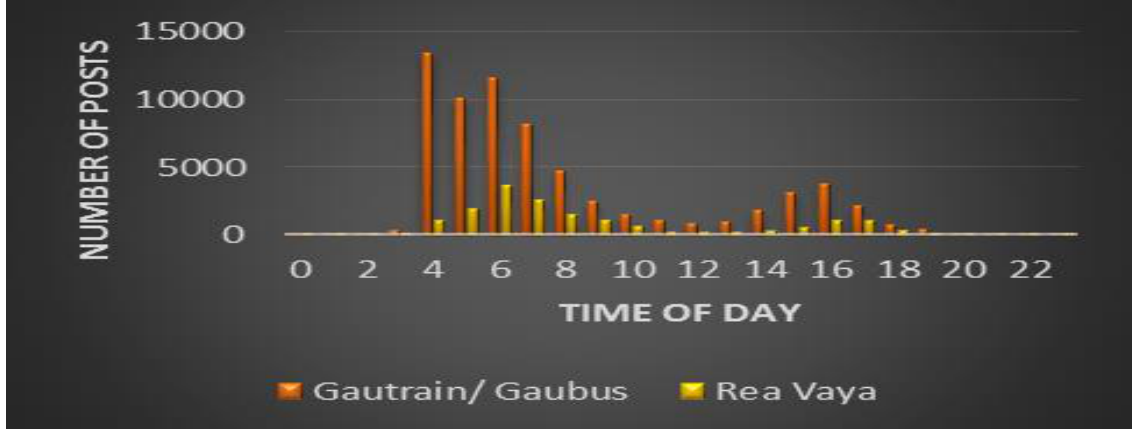
For the six month period in 2018, the highest numbers of trips both commuting and recreational occur in the during the morning peak for both modes of public transportation. This could be due to the commuters’ need for reducing the total travel time when going to work, school or making trips for administrative duties. From the content analysis, most of the posts made during this time are complaints are delays in travel time. From 12pm to 4pm, there is an increase in commuting trips, this Johannesburg there is usually an increase in traffic congestion during these times. This correlates to the results obtained from twitter, as most of the posts, related to traffic accidents on various major roads, and delays on the freeway. After 4pm there is a decrease in the number of posts. This could be due to having less commuters travelling during this time of day, as most commuters leave work at 4pm.